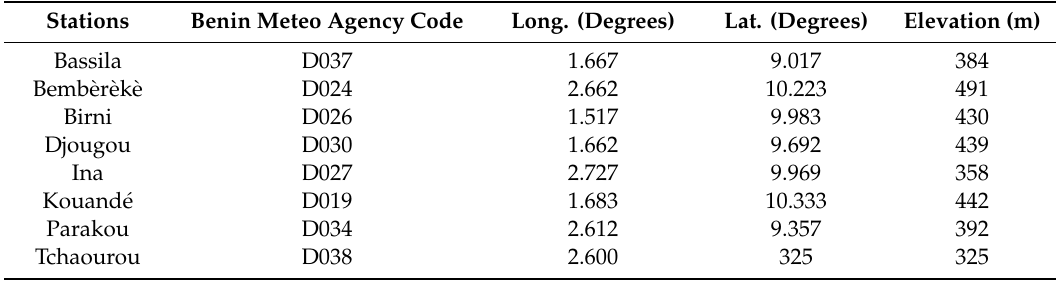
Table 1. List of selected stations in the upper Ouémé River basin.